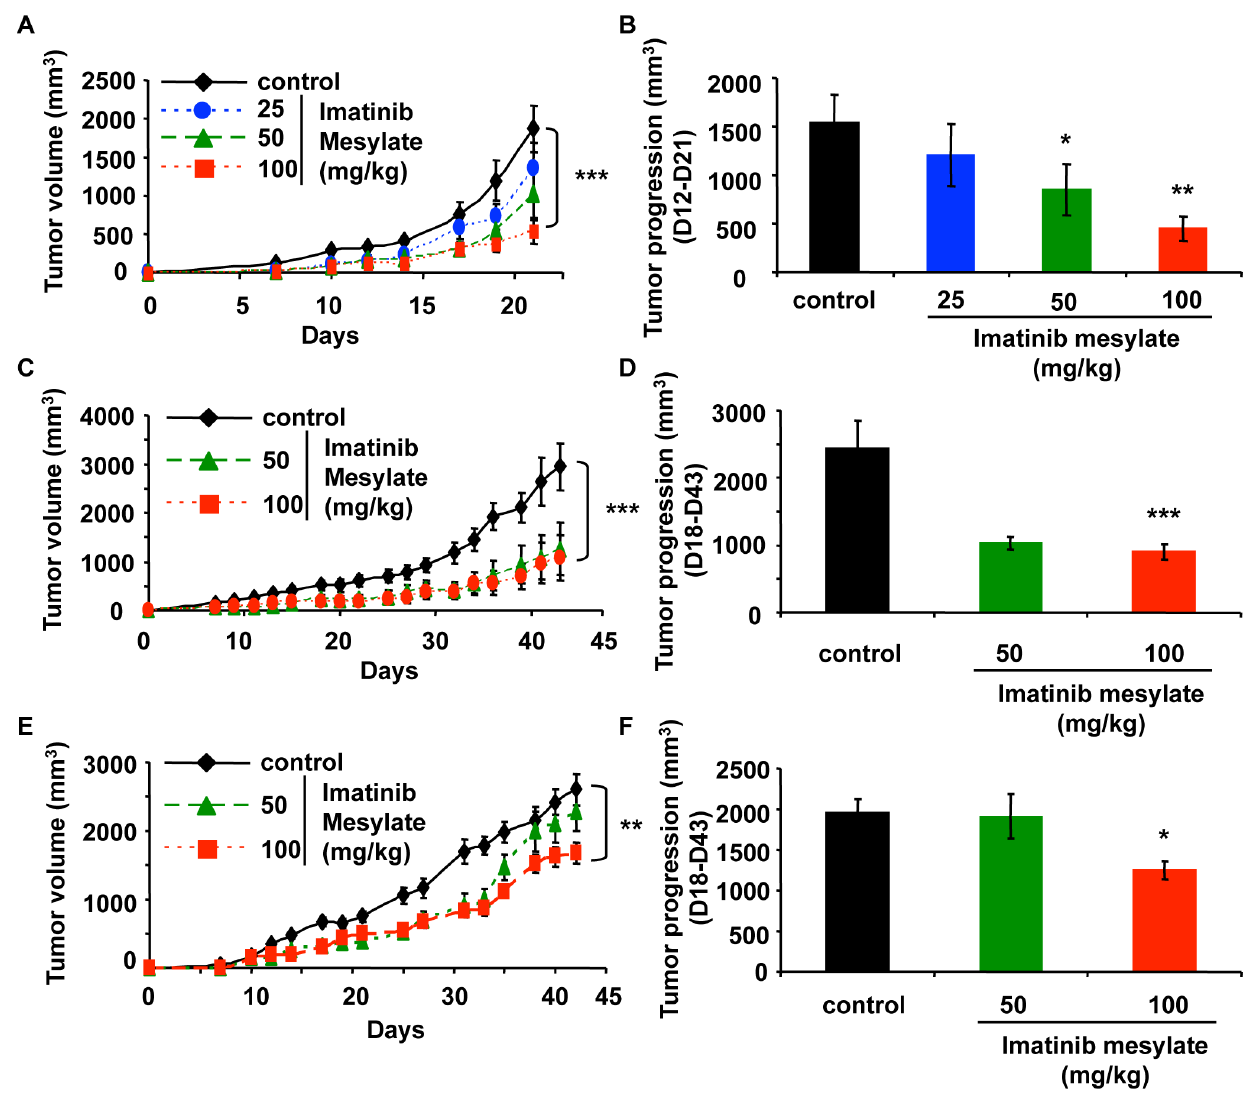
Figure 6. Imatinib mesylate inhibits osteosarcoma development in ‘‘preventive’’ and ‘‘curative’’ therapeutic context. Mice bearing undifferentiated POS-1 ( A, B ) or mixed osteoblastic/osteolytic MOS-J ( C–F ) osteosarcoma tumours (n=8 per group) were assigned as control (vehicle), or imatinib mesylate (25, 50 or 100 mg/kg, daily oral administration). The treatment started 1 day after tumour cell inoculation (« preventive » treatment, A–D ) or treatment started when tumours are palpable (7–10 days) named ‘‘curative treatment’’ ( E, F ). Evolution of tumour volumes (mm 3 ) (A, C, E); follow-up of tumour progressions (B, D, F). * P , 0.05; ** P , 0.01; *** P , 0.001.